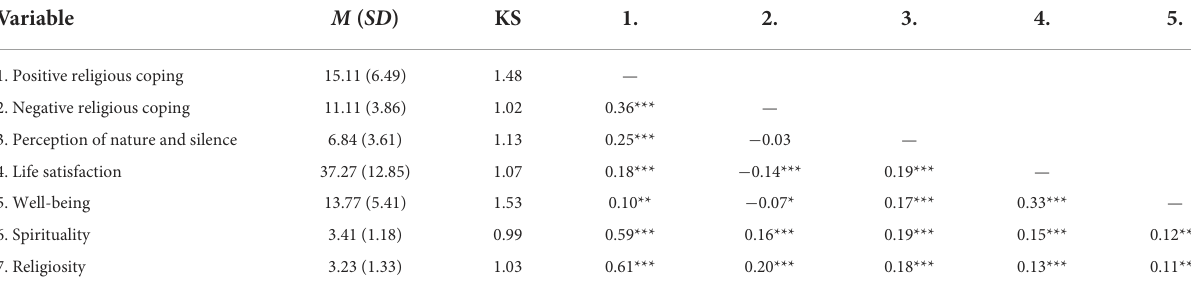
TABLE 1 Means and